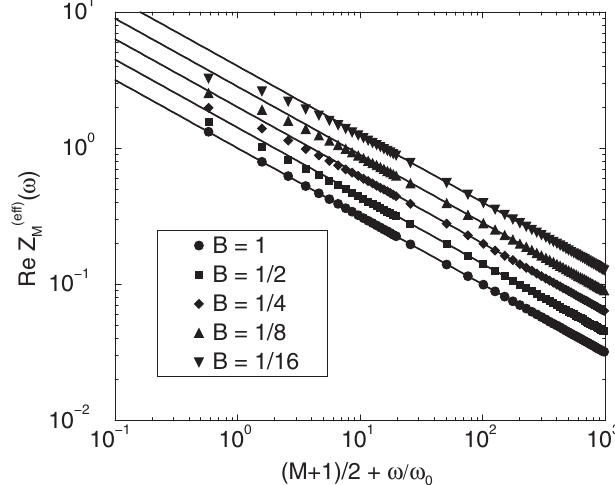
FIG. 2. Real part of resistive wall effective impedance. Solid lines represent fit